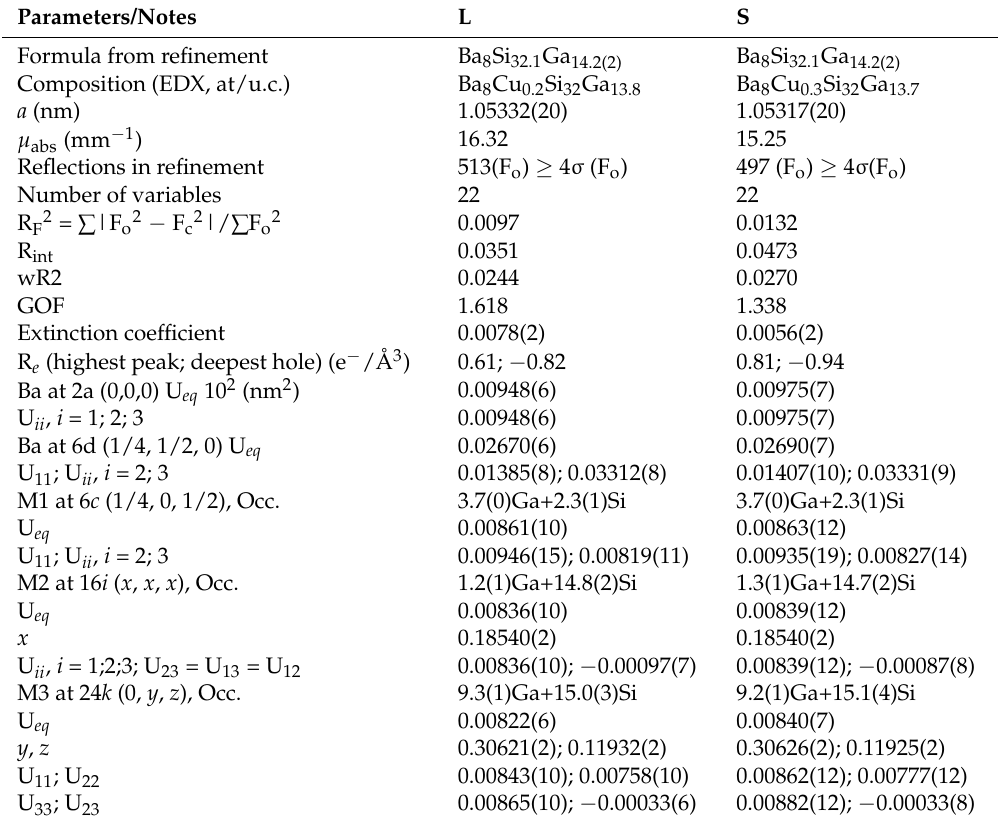
Table 1. Structural data for the two single crystals (L and S) with approximate compositions Ba 8 Si 32.1 Ga 14.2(2) and Ba 8 Si 32.1 Ga 14.2(2) derived from X-ray single crystal refinements. Data